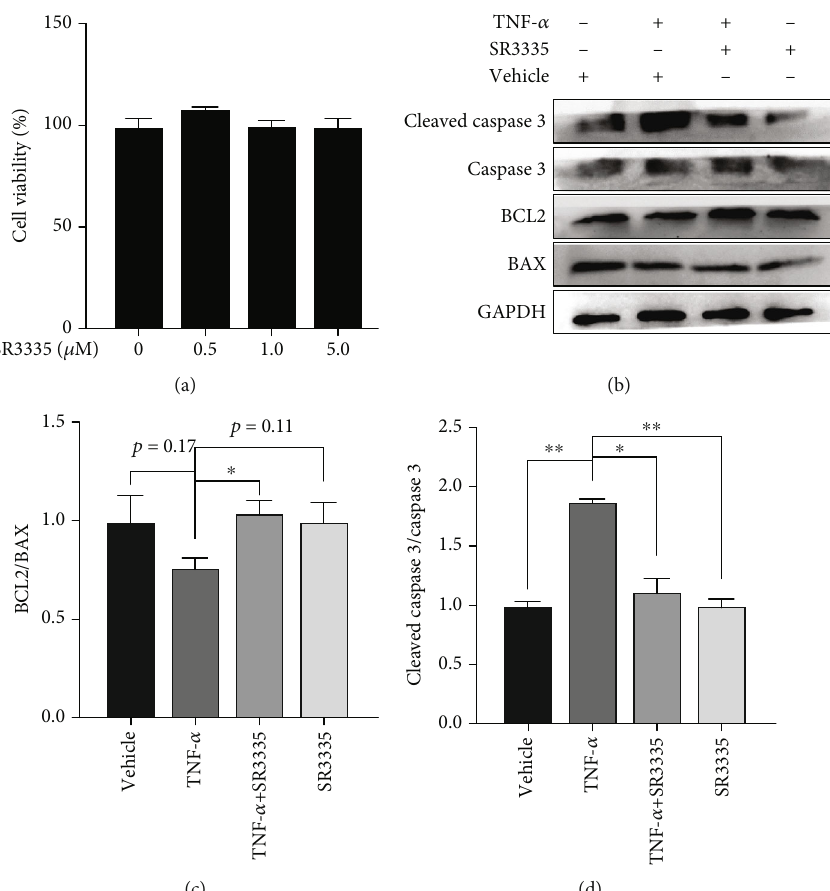
Figure 4: E ff ect of SR3335 on NP cell viability and apoptosis. (a) NP cells were treated with the indicated concentration of SR3335 (0.5, 1.0, and 5.0 μ M), and the cell viability was measured with the CCK-8 assay. N = 3 . (b) The NP cells were pretreated with 1 μ M of SR3335 2h before 10ng/ml TNF- α treatment. The protein level of cleaved caspase 3, caspase 3, BCL2, and BAX was measured by the western blot. (c) Quanti fi cation of BCL2 and BAX. The ratio of BCL2/BAX was measured. ∗ p < 0 : 05 compared with the TNF- α group. (d) Quanti fi cation of cleaved caspase 3 and caspase 3. The ratio of cleaved caspase 3/caspase 3 was measured. ∗ p < 0 : 05 or ∗∗ p < 0 : 01 compared with the TNF- α group. Data are expressed as mean ± SD . All experiments were repeated three